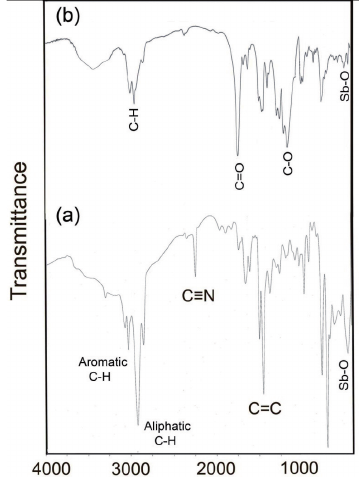
Figure 9. FT-IR spectrum of (a) ABS/Sb 2 O 3 -Br, (b) PMMA/Sb 2 O 3 -Br compound.